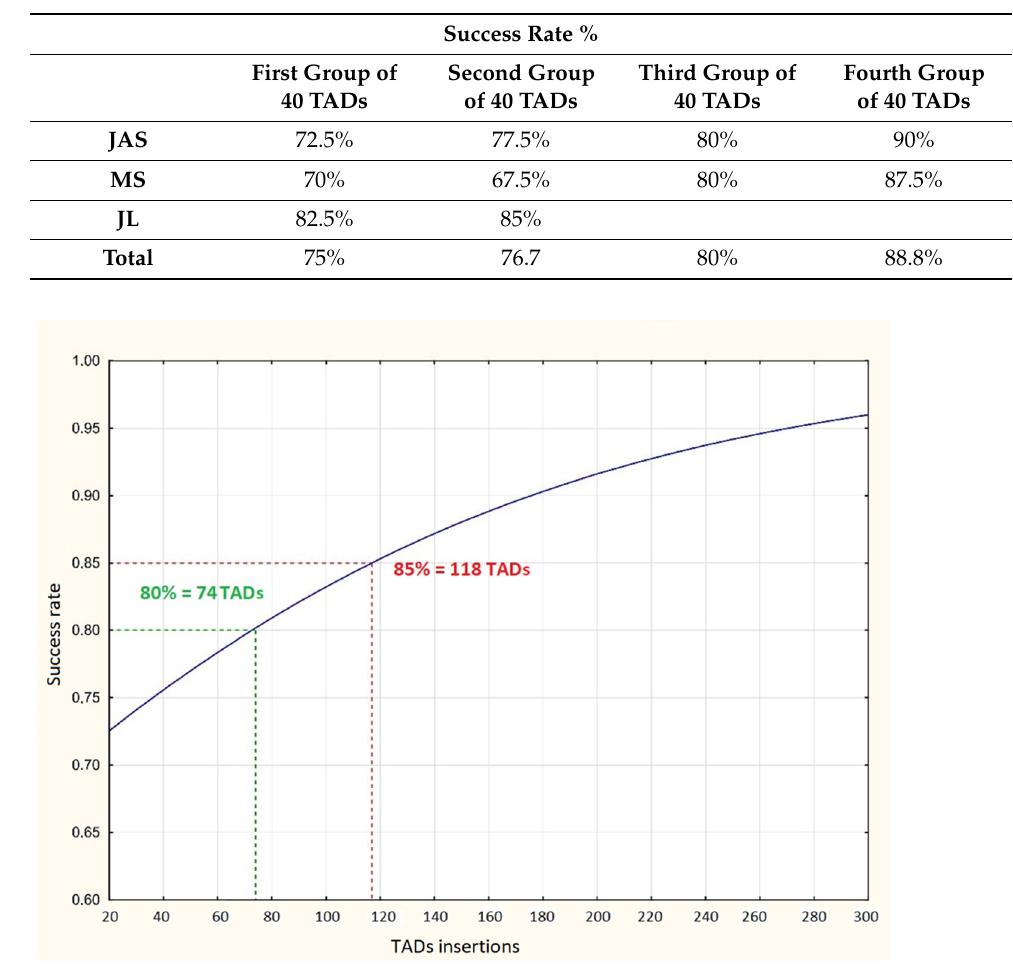
Figure 1. Total learning curve in TAD insertion—logistic regression model.